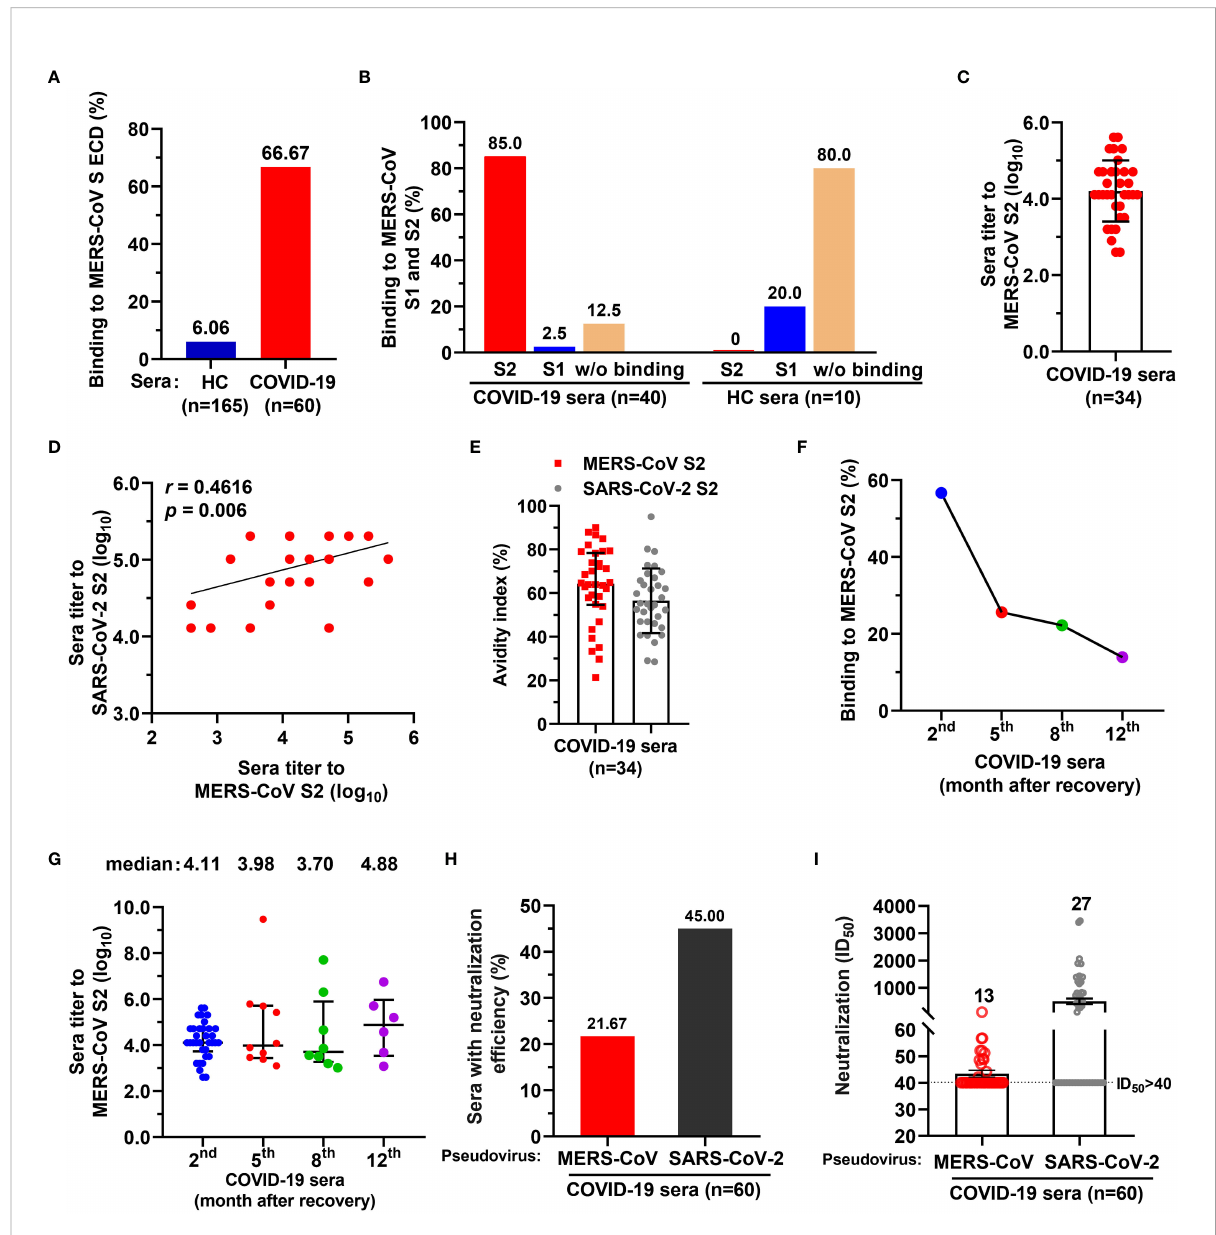
FIGURE 1 A proportion of serum antibodies from COVID-19 convalescents had binding activity to MERS-CoV spike S2 subunit and neutralized spike pseudoviruses. (A) A proportion of COVID-19 sera showed binding activity to MERS-CoV spike (S) extracellular domain (ECD). Sera from COVID- 19 convalescents (n=60) and healthy control (HC) blood donors (n=165) (both at 1:1000 dilution) were tested for binding to MERS-CoV S ECD by ELISA. The percentage of sera binding to MERS-CoV S ECD are shown. Data are the average values from two independent experiments. (B) The percentage of sera from COVID-19 convalescents or HC reacted with MERS-CoV S1 and/or S2. (C) Endpoint titer of serum IgGs from COVID-19 convalescents against MERS-CoV S2. (D) Correlation coef fi cient of endpoint titers for antibodies reactive with MERS-CoV S2 and SARS-CoV-2 S2. Pearson ’ s correlation, p <0.05 was considered statistically signi fi cant. (E) Avidity of COVID-19 convalescent serum antibody to MERS-CoV S2 and SARS-CoV-2 S2. (F) Dynamics of COVID-19 convalescent serum antibody after discharge. Binding activity of COVID-19 serum antibody against MERS-CoV S2 subunit was examined after discharge, at the 2 nd month (n=60), the 5 th month (n=39), the 8 th month (n=36), and 12 th month (n=43). (G) Endpoint titers of COVID-19 convalescent serum antibody for MERS-CoV S2 after discharge from hospital. The convalescent sera were tested at the 2 nd month (n=34), the 5 th month (n=10), the 8 th month (n=8), and 12 th month (n=6). One-way ANOVA with Tukey ’ s post hoc test was used. (H) The percentage of COVID-19 convalescent serum IgG antibody with neutralizing activity for MERS-CoV and SARS-CoV-2 spike pseudoviruses. ID 50 >40 was considered positive for neutralization (21.67% [13/60] and 45% [27/60], respectively). (I) Neutralization titers of 13 COVID-19 convalescent serum antibodies for MERS-CoV and SARS-CoV-2 spike pseudoviruses. ID 50 >40 was considered positive for neutralization. For panels C , D , and G , endpoint titers were log 10 -transformed; for panels C , E , G and I , data are median±IQR (25 – 75%) and the error bars indicate median with interquartile range